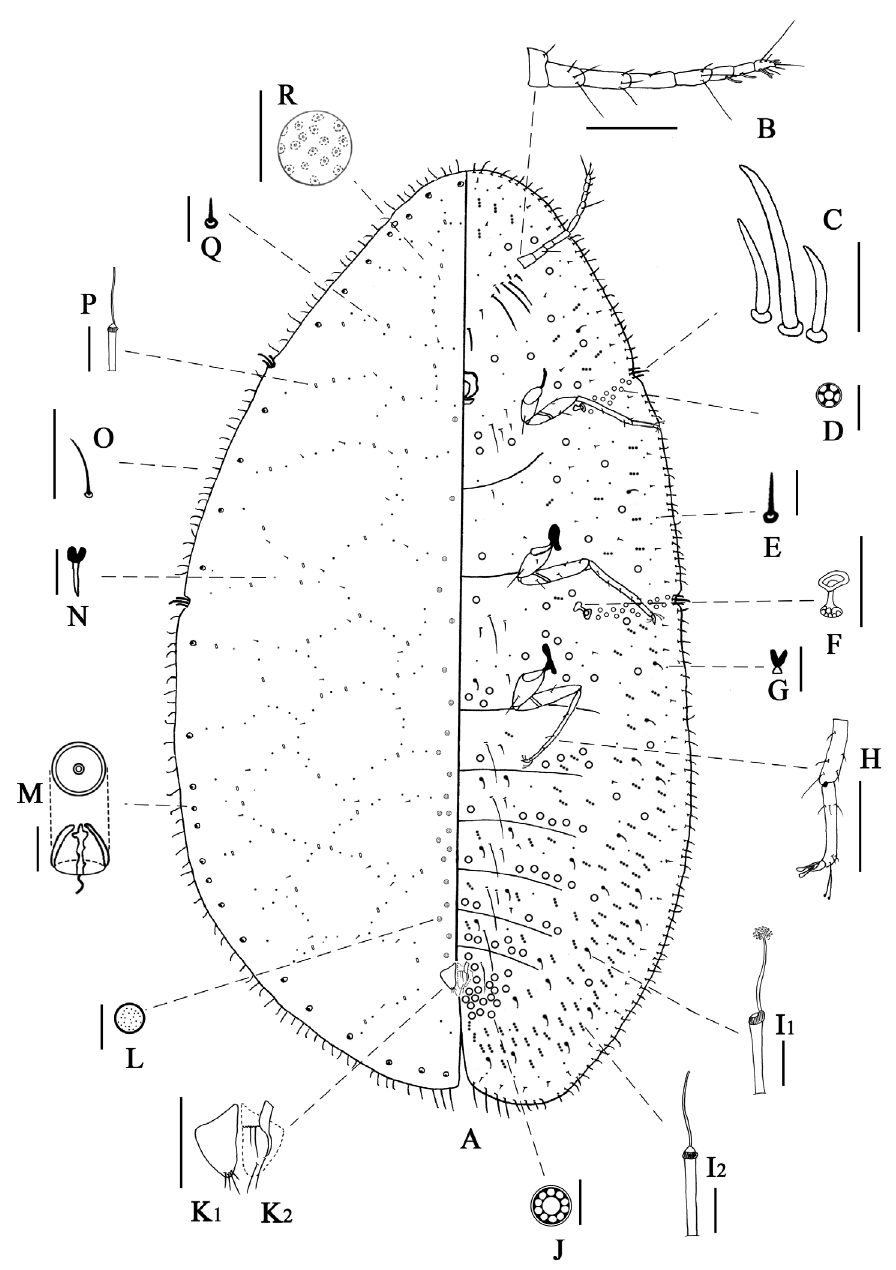
Figure 2. Adult female of Leptopulvinaria sapinda sp. n., A body derm B antennae C stigmatic spine D spiracular pore E submarginal seta F spiracle G ventral microduct H leg I J multilocular pore K anal plate K ano-genital fold L preopercular pore M dorsal tubercle N dorsal 1 2 microduct O marginal setae P dorsal tubular duct Q dorsal seta R dermal areolation. Scale bars: 200 µm ( B, F, H, K, R ); 20 µm ( C, O ); 10 µm ( D, E, G, I, J, L, N, P, Q except A